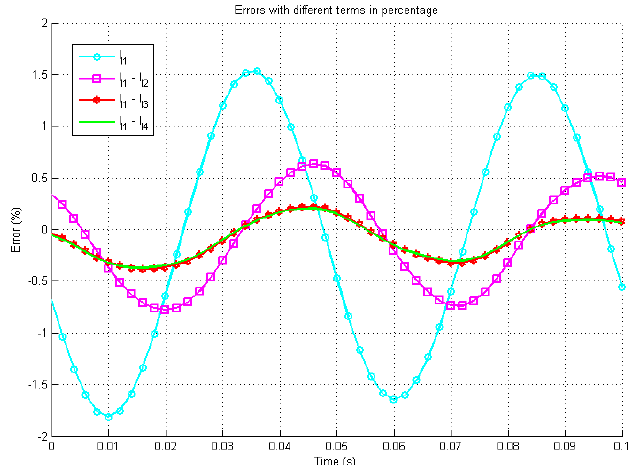
Figure 9. Errors between the experimental data and the iterative solutions.